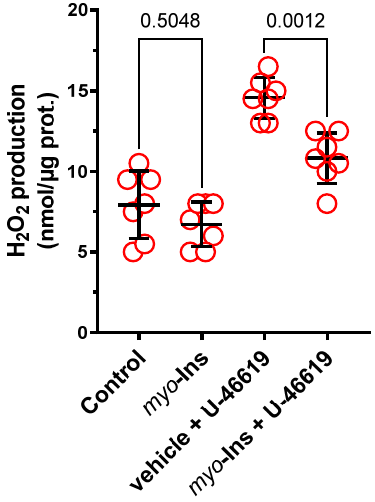
Figure 5. The effect of pre-incubation with myo -inositol (1.0 µ M) on the production of hydrogen peroxide (H 2 O 2 ) in control arteries and arteries subjected to U-46619. Results (means ± SD) are expressed as nanomoles of H 2 O 2 per microgram of protein. Number of animals: n = 6–8.